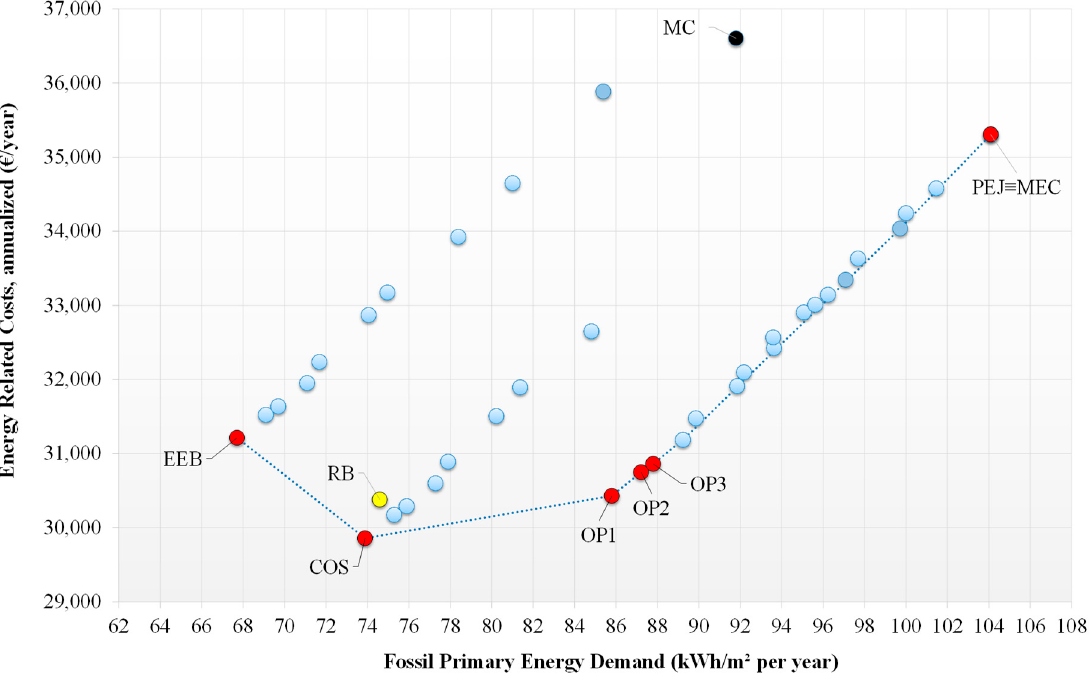
Figure 4. Annual energy-related costs against primary energy demands for different EEMs analyzed for the colder climatic zone F, including a financial projection. Table 11. Detected optimal constructive solutions concerning different EEMs for climatic zone F (VWT, insulation thickness in vertical wall; GST, insulation thickness in the ground slab; SFT, insulation thickness in the second last floor; GS, glazing system).